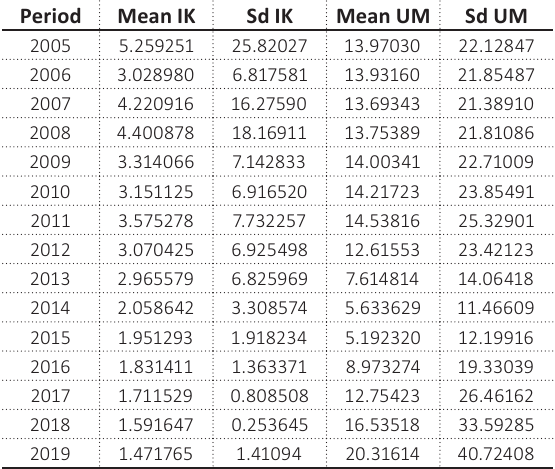
Table 2. Descriptive statistics of market uncertainty of the investment model